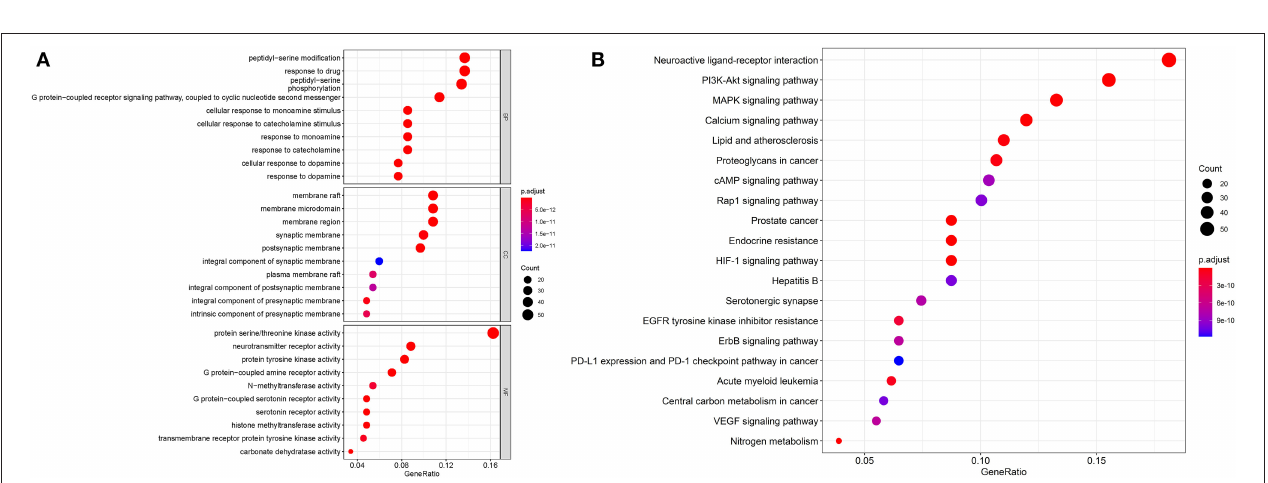
FIGURE 6 | The results of bioinformatics analysis. GO enrichment analysis of targets (A) , KEGG pathway enrichment analysis (B) .